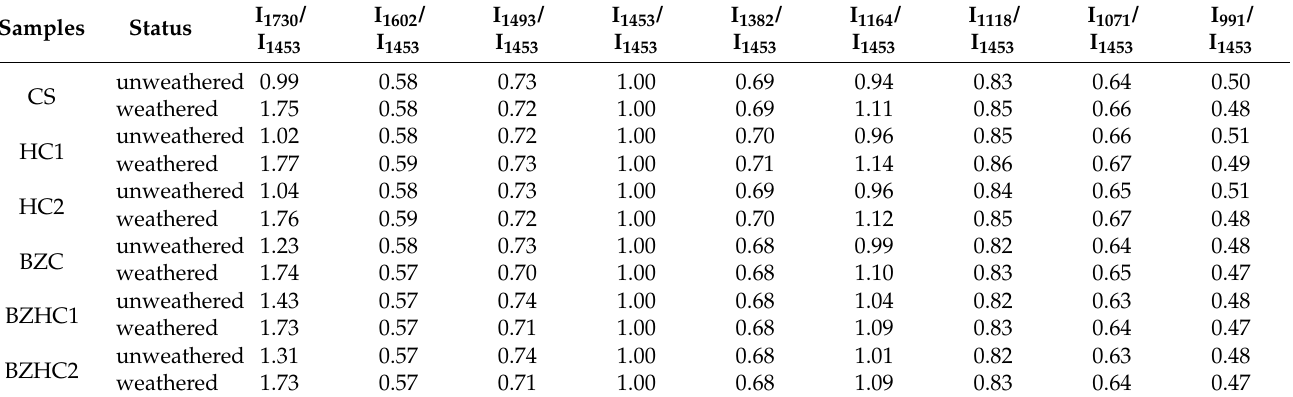
Table 3. Relative intensities of the FT-IR absorption peaks of